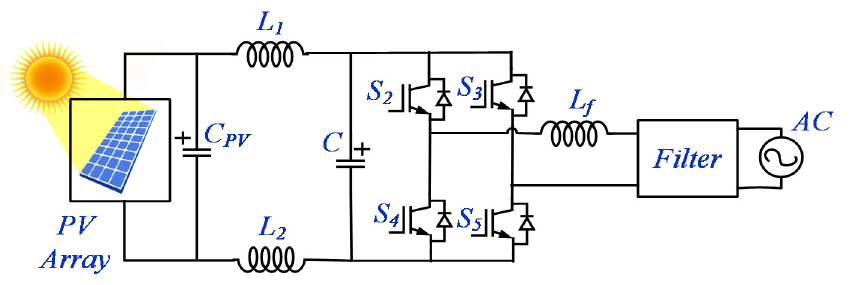
Figure 19. Single phase Z-source inverter .